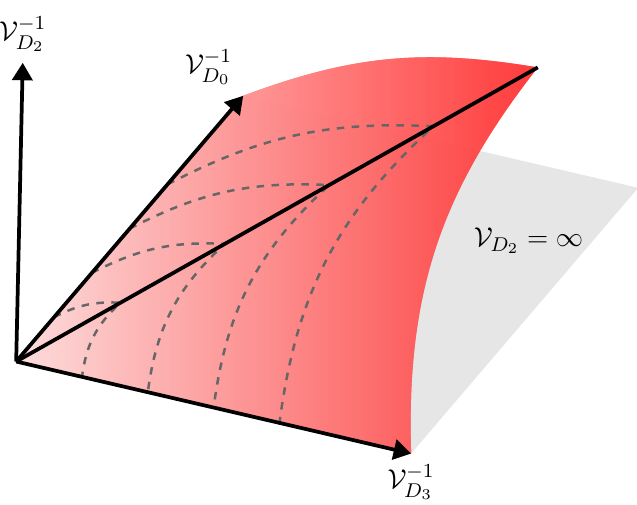
Figure 5. A sketch of part of the Kähler field space for B 3 = P 1 → Bl ( F n ) with u = 0